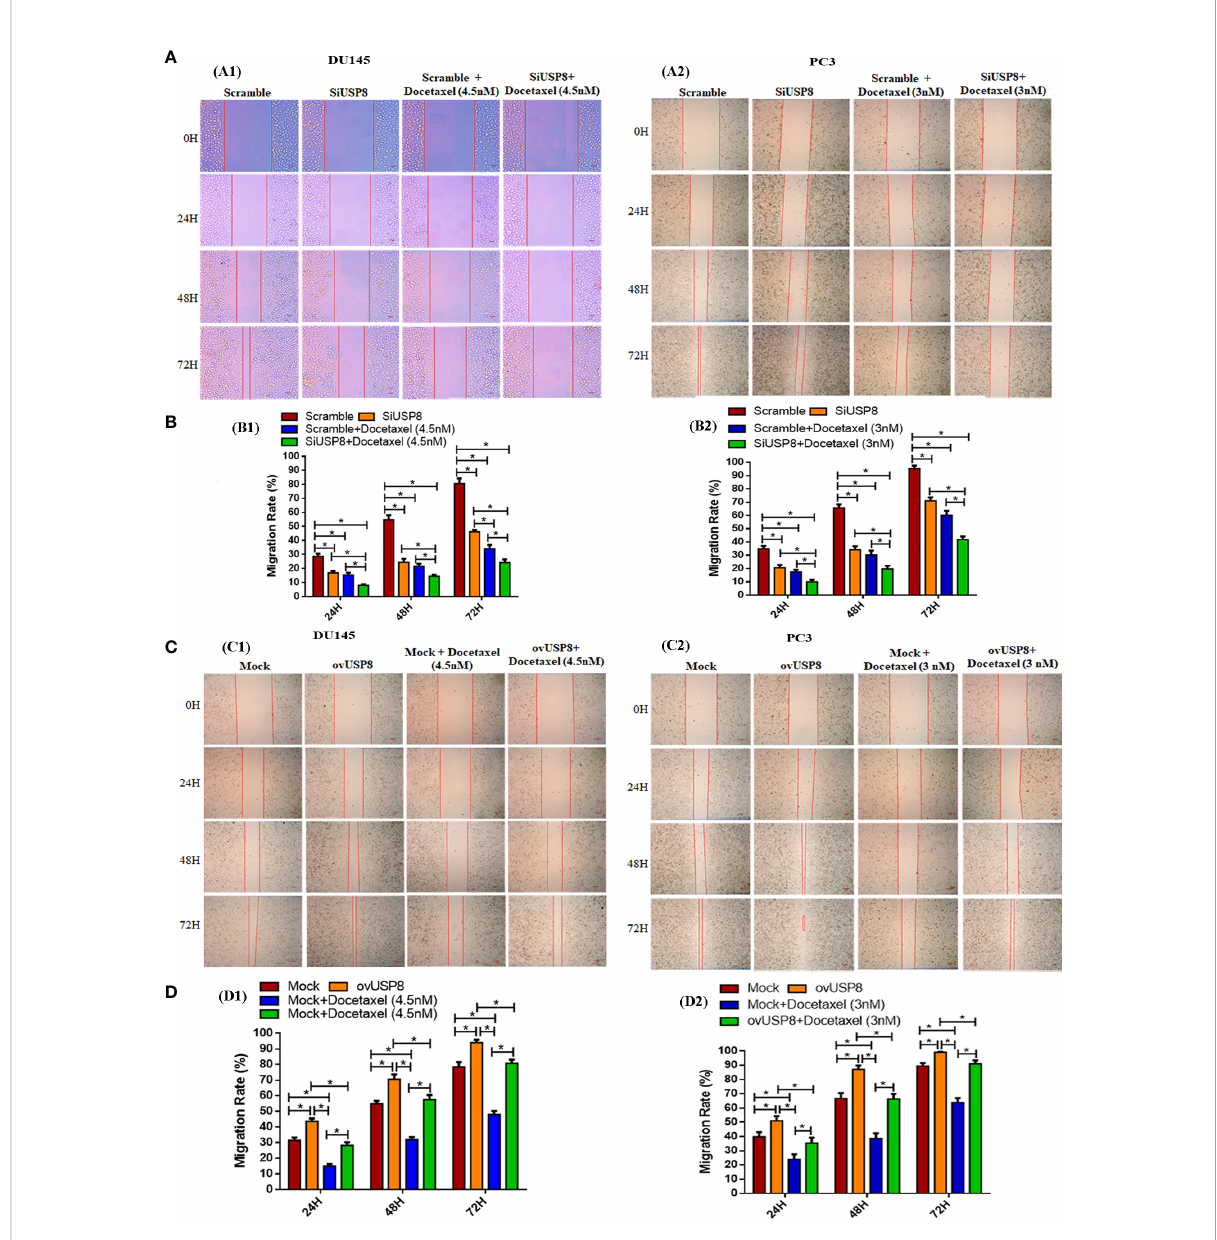
FIGURE 2 Regulation of PCa cell migration by USP8, and wound healing action of docetaxel. (A) PCa cells DU145 and PC3 were transfected with either scrambled or SiUSP8, and wound healing assay was employed followed by with or without docetaxel therapy (4.5 nM in DU145 and 3 nM in PC3) as described details in the methodology section. (B) The un-migrated area was measured by using ImageJ, and bar diagrams were plotted to represent the rate of cell migration of each independent experiment (n = 3, * p < 0.05). (C) PCa cells DU145 and PC3 were transfected with either mock vector or pCMV3-USP8-overexpressing vector, and wound healing assay was employed in the presence or absence of docetaxel (4.5 nM in DU145 and 3 nM in Pc3) as described details in methodology. (D) The un-migrated area was measured by using ImageJ, and bar diagrams were plotted to represent the rate of cell migration of each independent experiment (n = 3, * p <